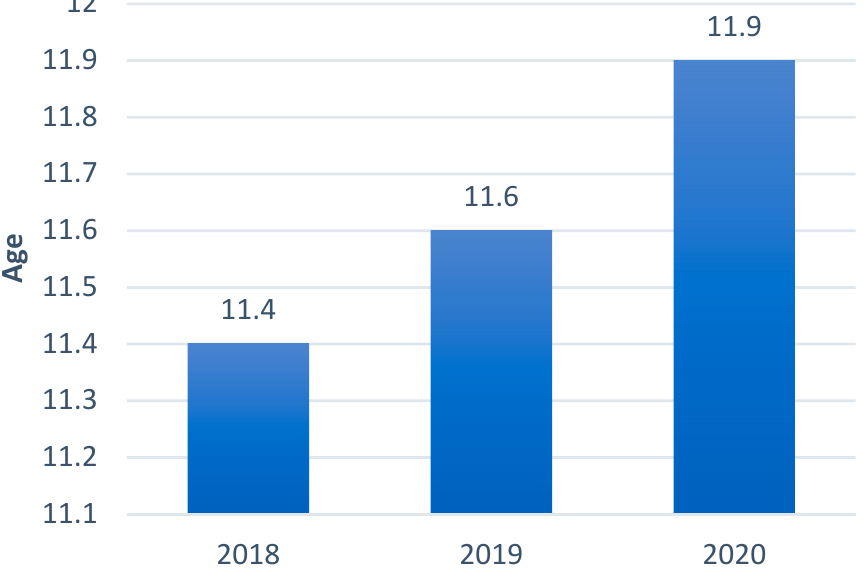
Figure 2. Average age of the EU fleet of vans . Source: ACEA [87].